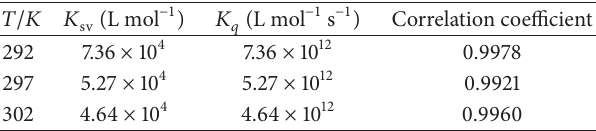
Table 1: Stern-Volmer quenching constants for the interaction of TRES with BSA at different temperatures.